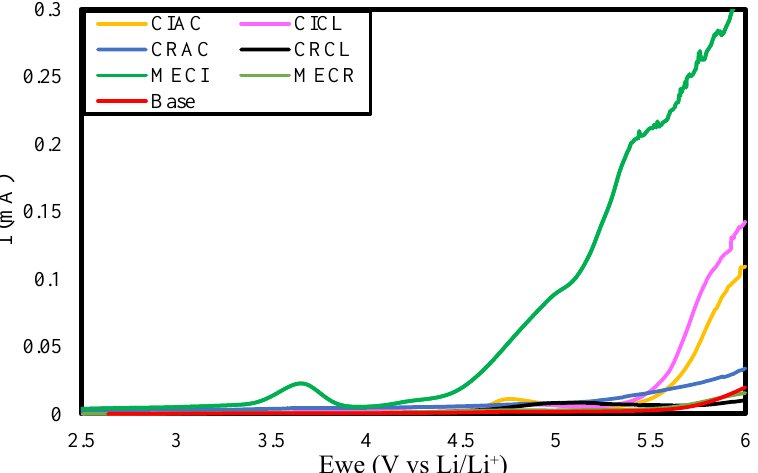
Figure 3. Comparing the oxidation stabilities of the selected SEI-forming compounds with the base electrolyte through the LSV experiment.